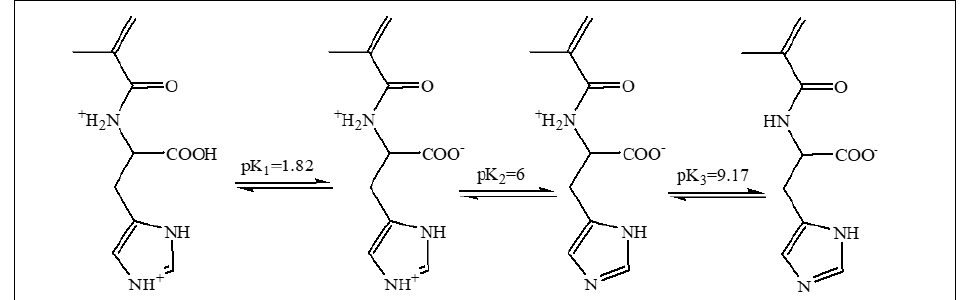
Figure 3. Swelling ratio of hydrogels at 37 °C, pH = 5 ( A ) and deswelling ratio of hydrogels at 37 °C, pH = 7.4 ( B ).